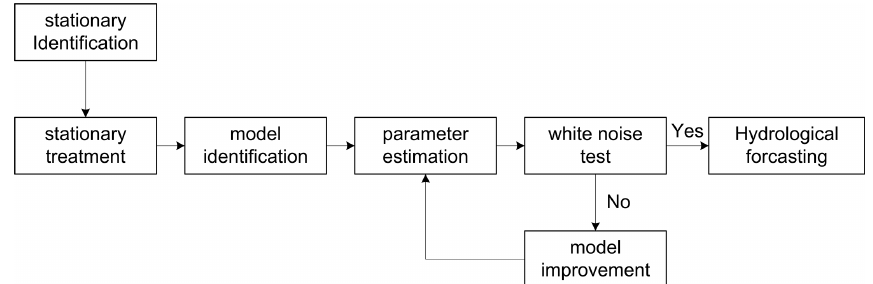
Figure 1. Procedure of applying ARIMA